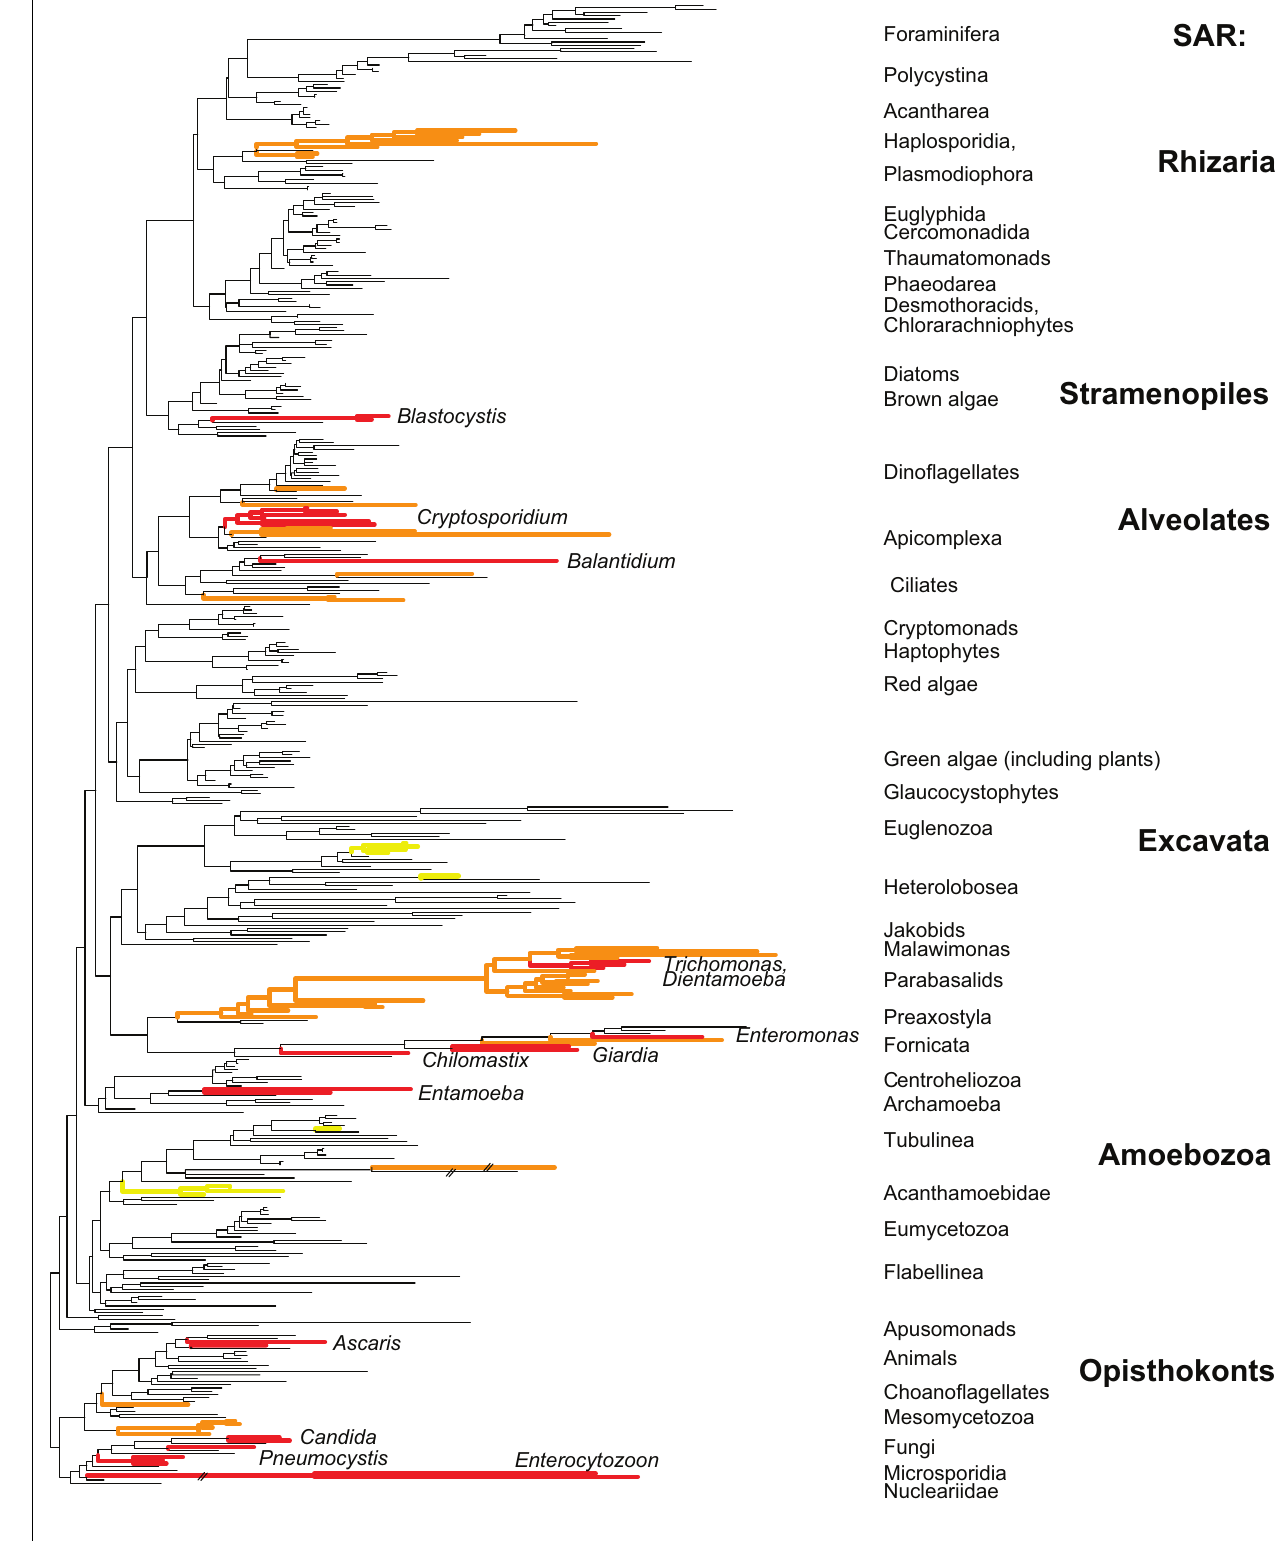
FIGURE 1 | Distribution of host-associated taxa across a broadly sampled eukaryotic tree of life. Red branches represent lineages found in the vertebrate gut with human-associated genera listed. Orange branches